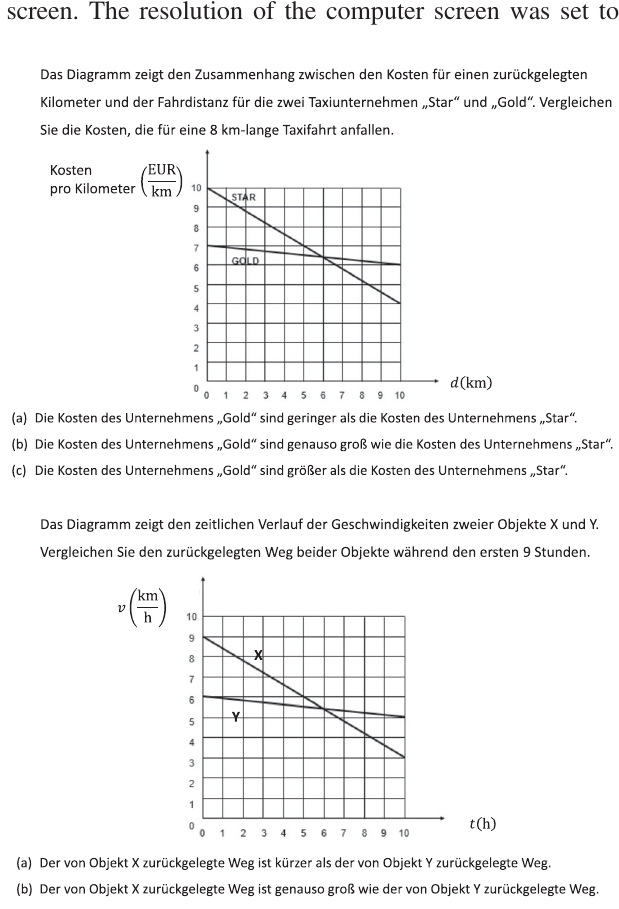
FIG. 1. An isomorphic pair of qualitative questions about the area under a